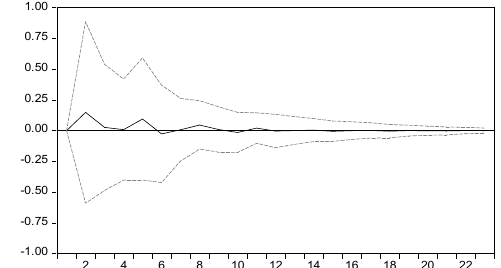
Figure 4. Response of LOAN to CONFI Figure 5 shows the impulse response of CAP to CONFI . It can be seen from figure 5 that after a shock to CONFI in this period, the CAP will have cyclical positive and negative alternate effects in the early stage, and the growth rate of China's direct use of foreign capital will be negatively affected by the foreign risk aversion. However, when the negative impact of the FDI growth rate peaks, this negative impact gradually weakens until it gradually develops. As the peak decreases, this effect changes periodically, eventually converges to the zero axis and the effect